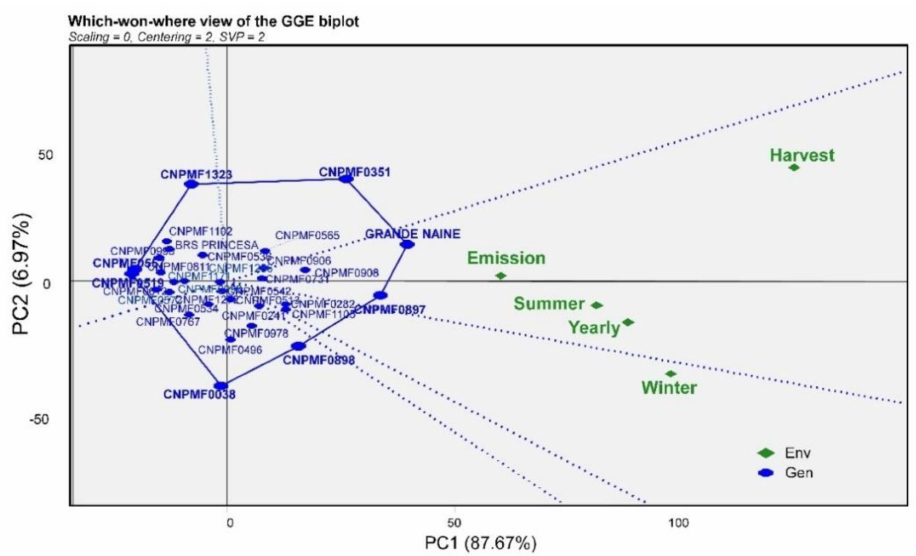
Figure 2. Interaction of the genotypes × environments biplot showing the performance of 32 banana genotypes based on the severity of Pseudocercospora fijiensis evaluated by different selection criteria according to visualization “who won where”. The biplot was based on the decomposition of a singular value (Scaling = 1, Centering = 2). The partition of the singular value focused on the dotted line (SVP = 2) was used. The analysis was performed based on the data from the internal disease index (ID). Code: Env: environment; Gen: genotype, using the GGEBiplotGUI package in the R statistic